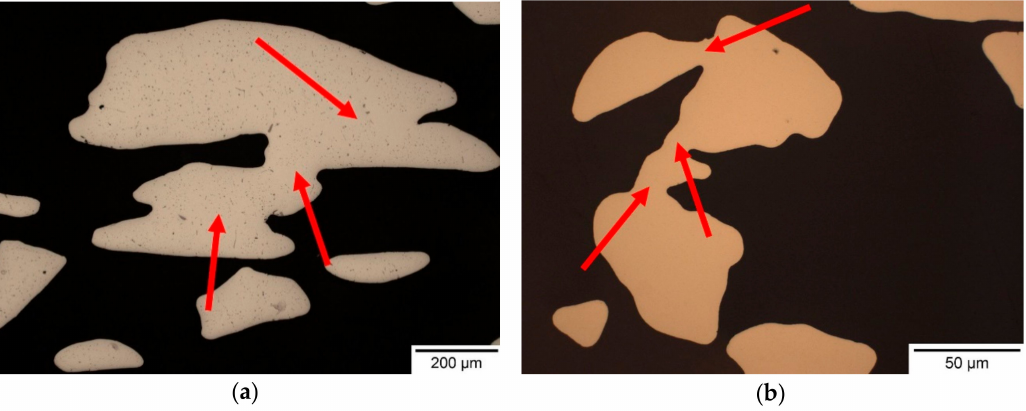
Figure 9. Cross section of ( a ) an AlSi1 short-fiber structure and ( b ) copper long-fiber structure. Arrows indicate selected fiber-to-fiber bonds.